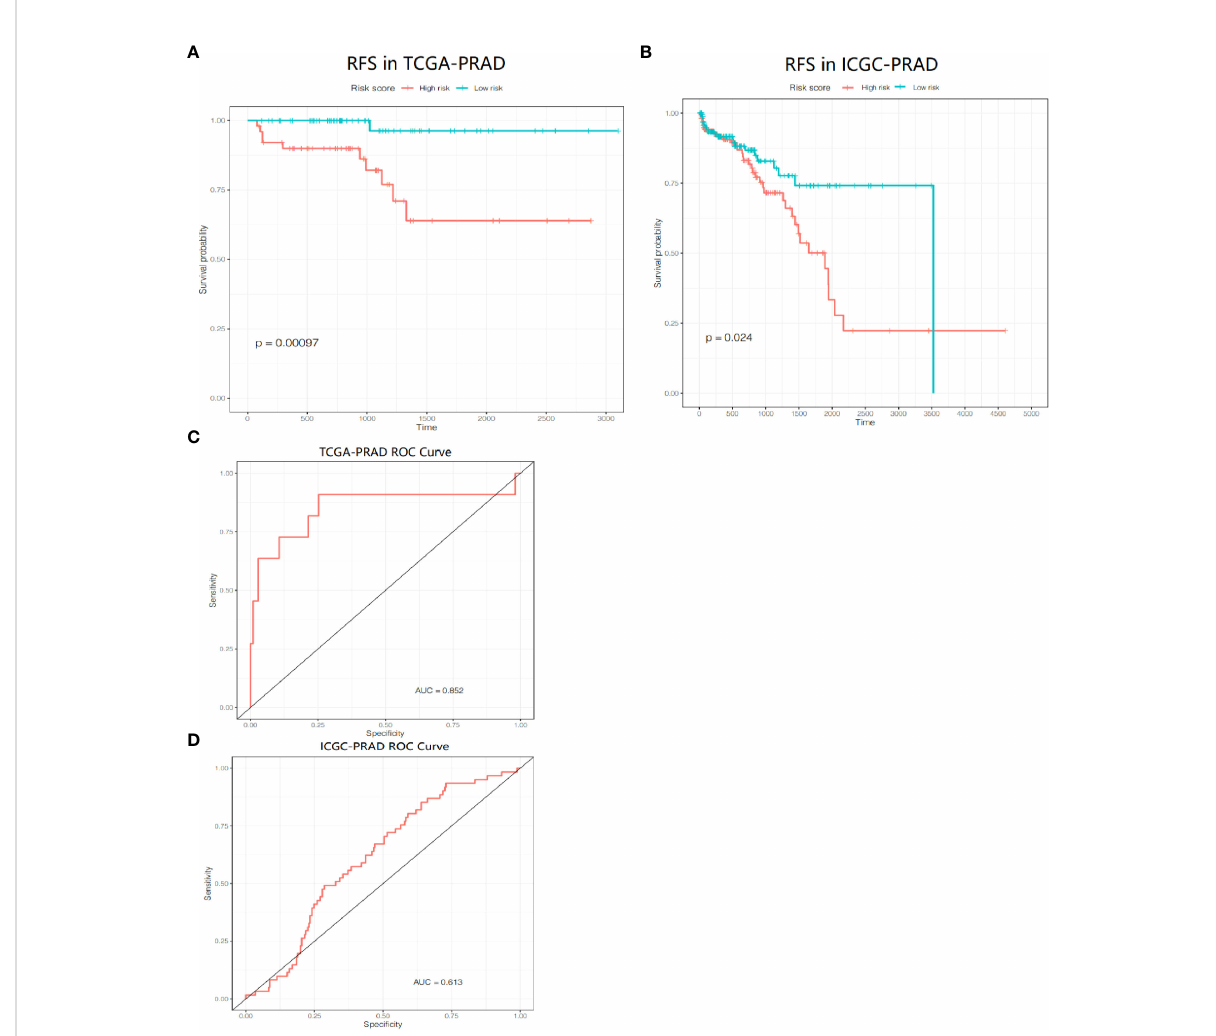
FIGURE 8 Prognositc value of the gene signature. (A) Kaplan-Meier curves for the RFS of patients in the two subgroups in the TCGA-PRAD cohort. (B) AUC of ROC curves demonstrated the prognostic value of the risk score in the TCGA-PRAD cohort. (C) Kaplan-Meier curves for the RFS of patients in the two subgroups in the ICGC-PRAD cohort. (D) AUC of ROC curves demonstrated the prognostic value of the risk score in the ICGC-PRAD